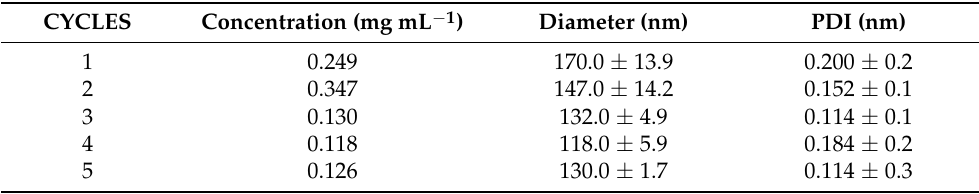
Table 6. Yield and size of MIP nanoparticles after five successive cycles and elution at pH 8.0. For the measurements of size PDIs were